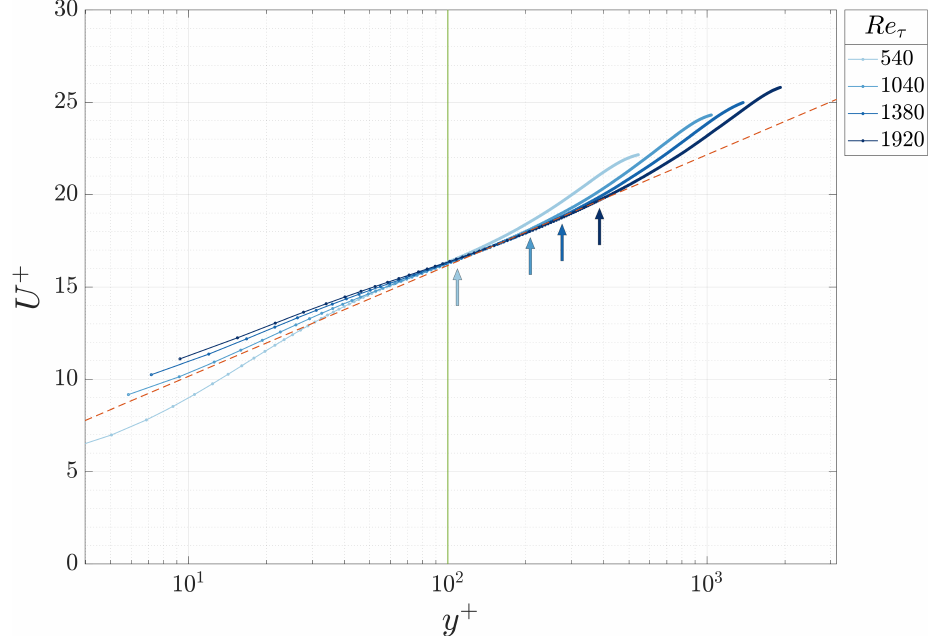
Figure 4. Profiles of the incoming mean streamwise velocity scaled in inner units, U + , for four different Re τ . The red dashed line is the log law curve, U + = 1 B = 4.17 [27]. The vertical arrows demarcate the y + = 0.2 Re τ outer edges of the log layers for the correspondingly colored profiles, whereas the green vertical line demarcates the inner boundary of the log layer at y + =